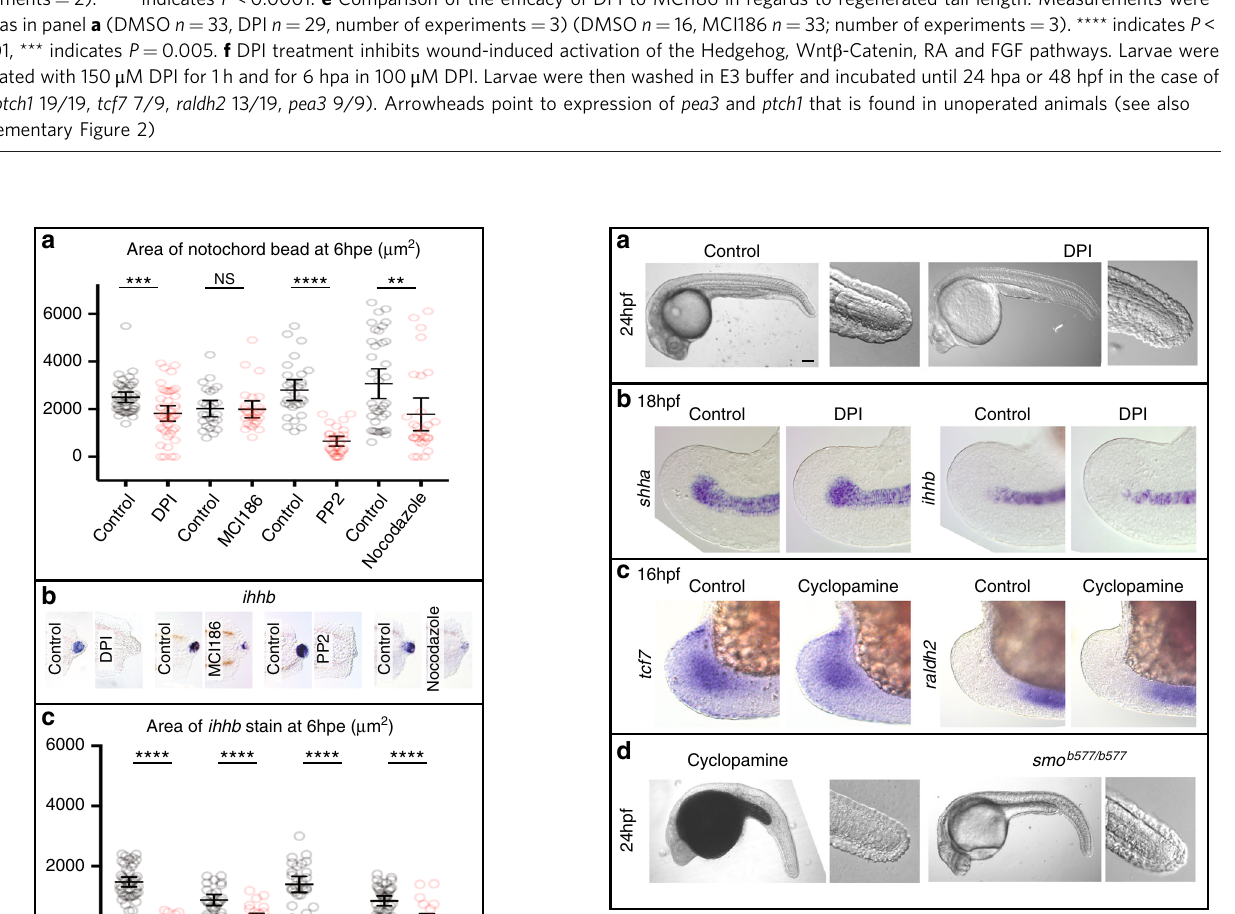
contraction along the anterior/posterior axis which results a build-up of pressure within the trunk of the fi sh. Given that the notochord sheath forms a tube-like structure, compaction along the anterior/posterior axis could build up pressure and force notochord cells rapidly out of the open end. The driving force for contraction may be the mass movement of epithelial cells towards the stump that has been described after fi n fold excision 42 . The